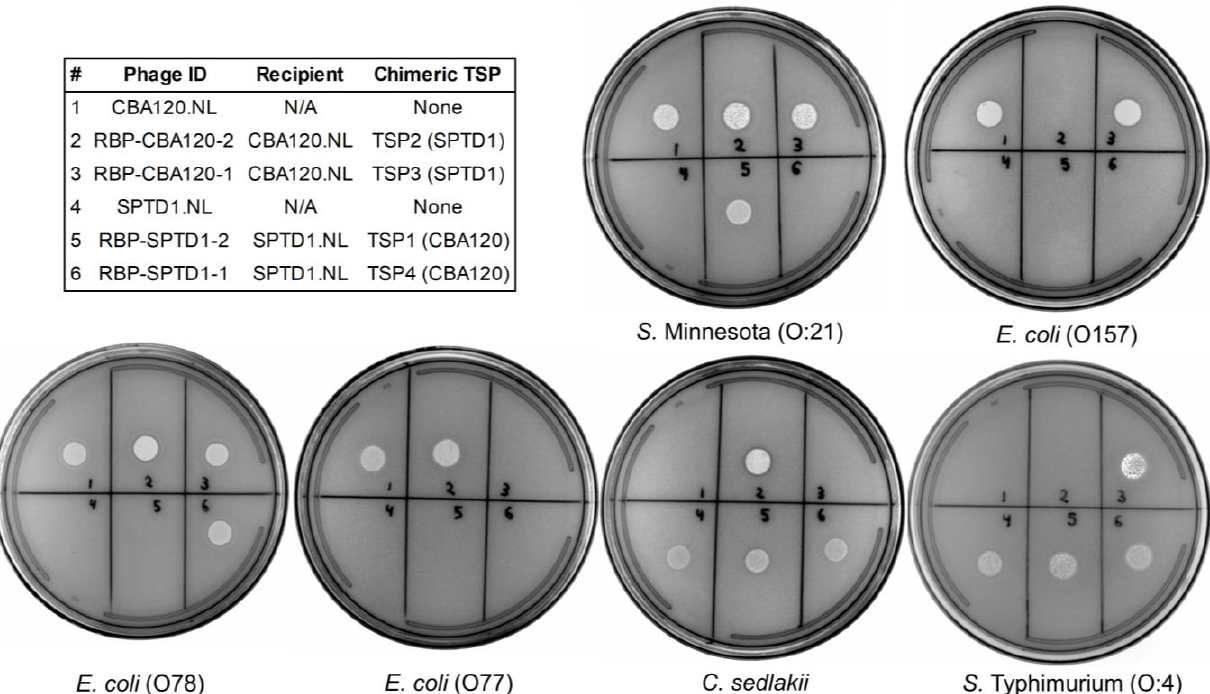
Figure 3. TSP chimeras are functional and allow customization of phage host range. Each phage preparation (1 × 10 8 PFU/mL) was tested for specificity by spotting 4 µL onto bacterial lawns. The appearance of a circular transparent spot is evidence of phage activity against the bacterial strain. Agar plates were imaged using a Gel Doc EZ Imager (Bio-Rad Laboratories, Hercules, CA, USA). The legend indicates the identity of each spot number (#), including the recipient phage and donor TSP. Bacterial strain information is provided separately (Table S1).